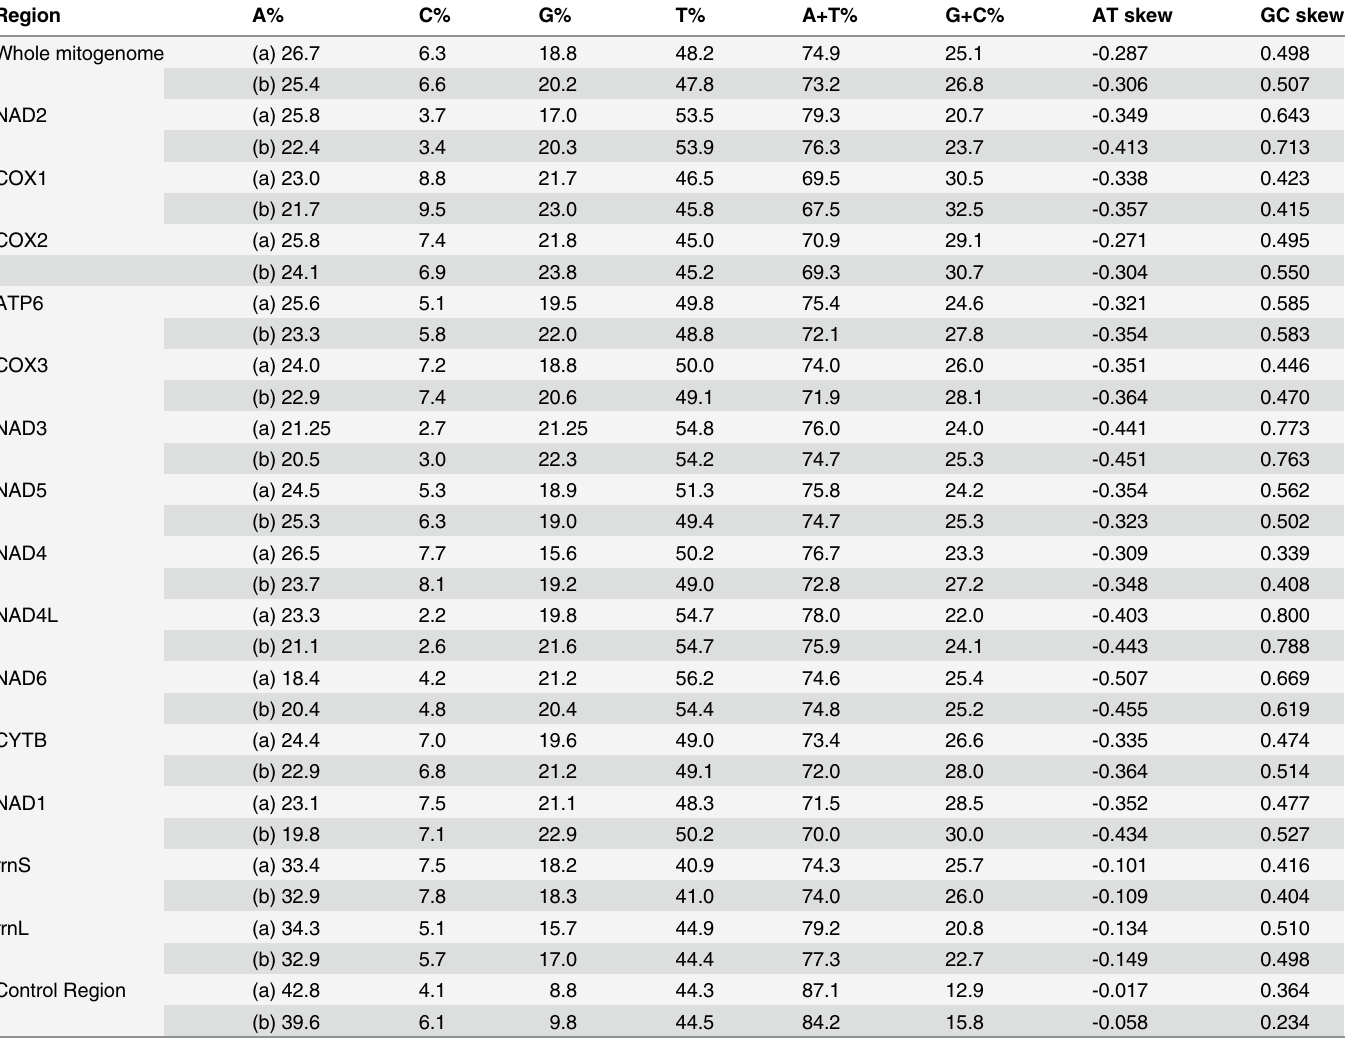
Table 3. Nucleotide composition of mitochondrial whole genome, protein-coding genes, rRNA genes and control region of Angiostrongylus cost- aricensis . (a) Costa Rica taxon; (b) Brazil taxon NC_013067. Region A% C% Whole mitogenome